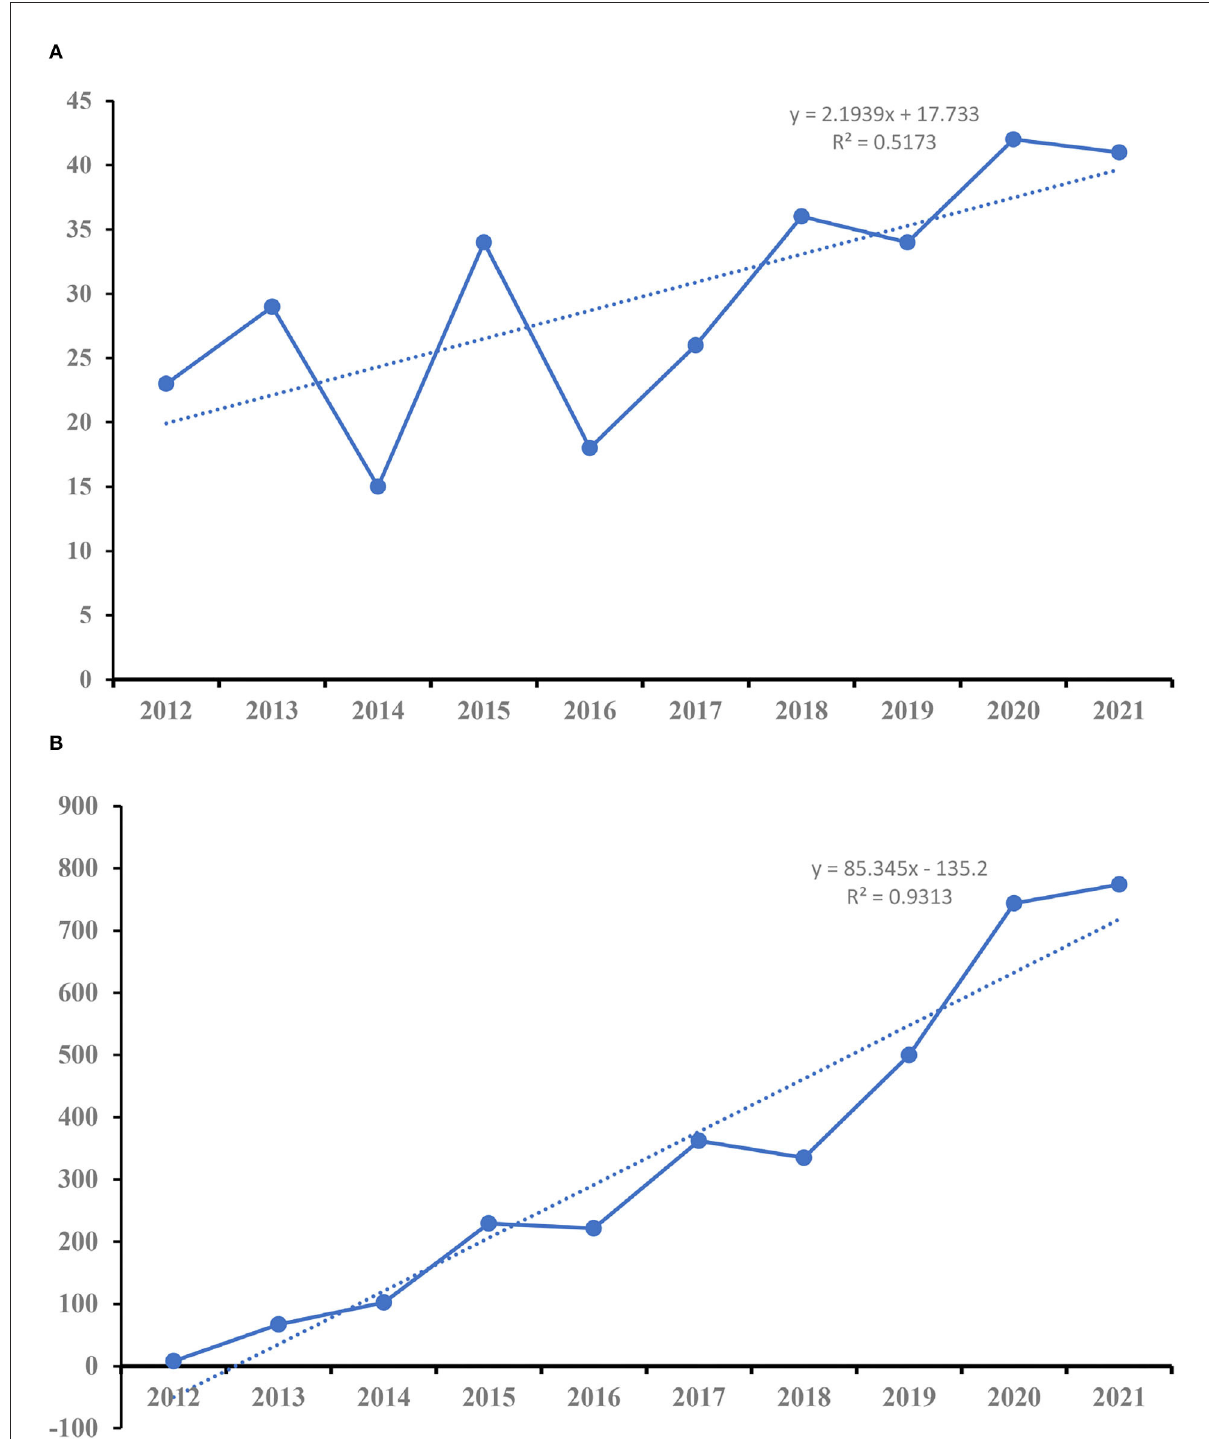
FIGURE2 The number of publications and citations. (A) The number of annual publications on included studies. (B) The number of annual citations on included